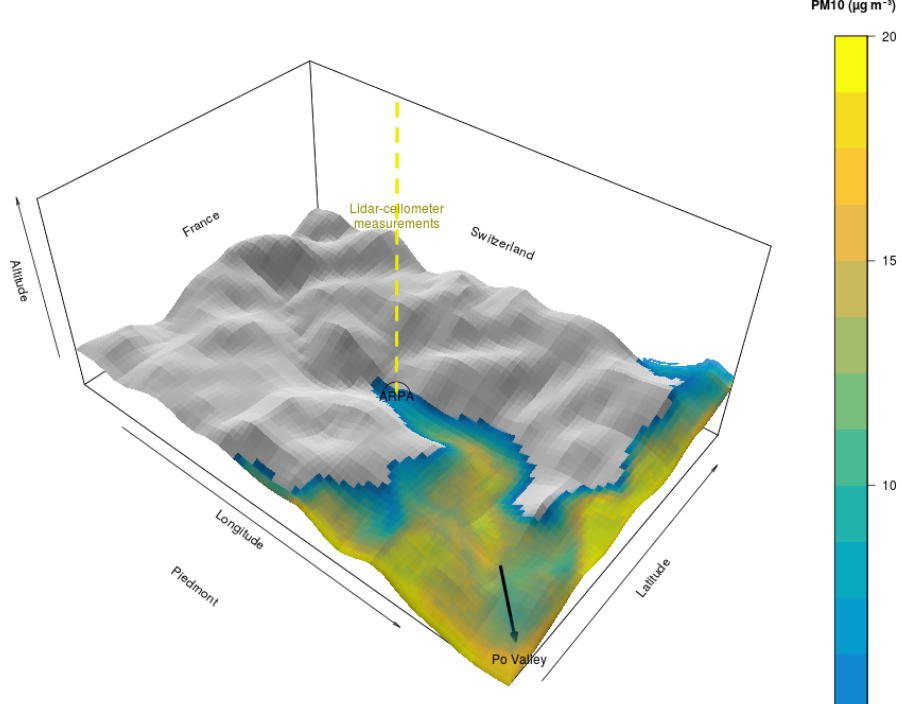
Figure 6. Still frame of the three-dimensional simulation of PM 10 concentration by FARM (image from 28 August 2015 at 15:00UTC). The image clearly shows the entrance of the aerosol-rich air mass from the Po basin into the Aosta Valley (yellow–blue area). The same colour scale as in Figs. 3d, 9d, and 12d is used (the lowest concentrations are removed for ease of representation). The sequence on 26– 31 August 2015 is available as a video file in the Supplement